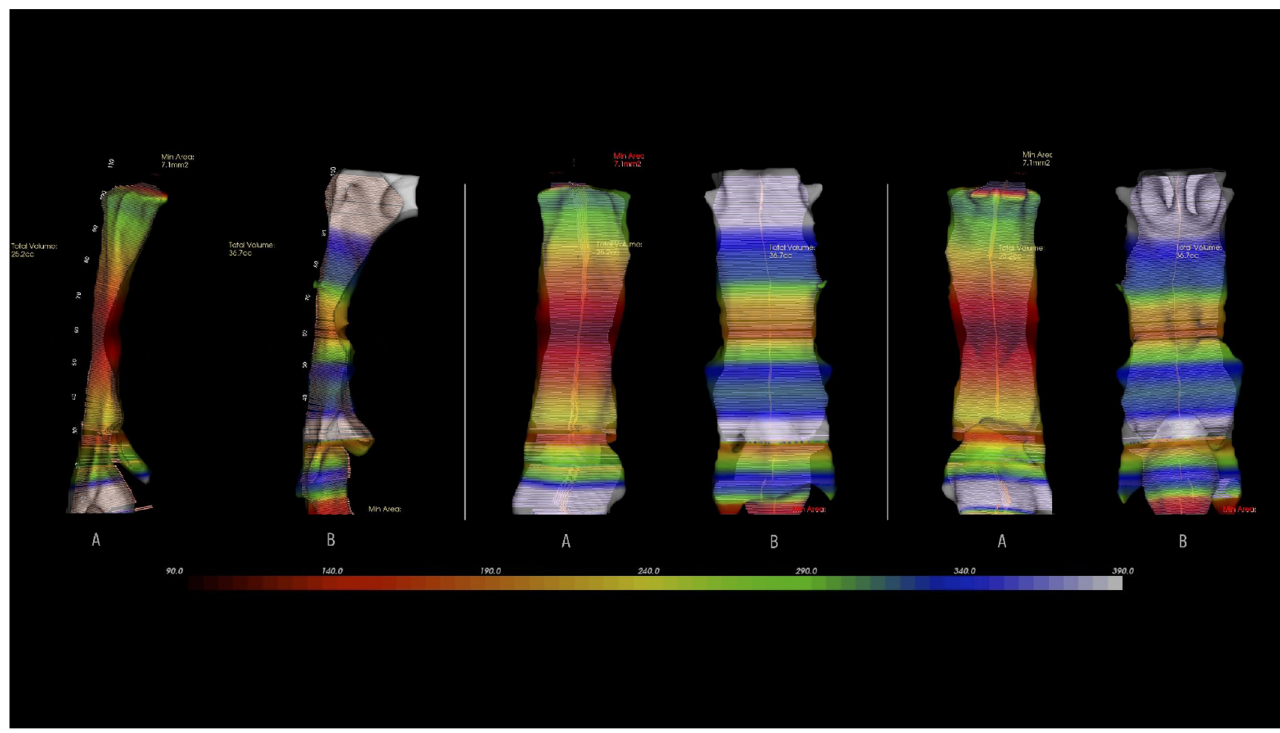
Figure 5. Three-dimensional rendering of the upper airway volume in lateral, anterior, and posterior views: pretreatment ( A ) and posttreatment ( B ) with the mandibular advancement device.